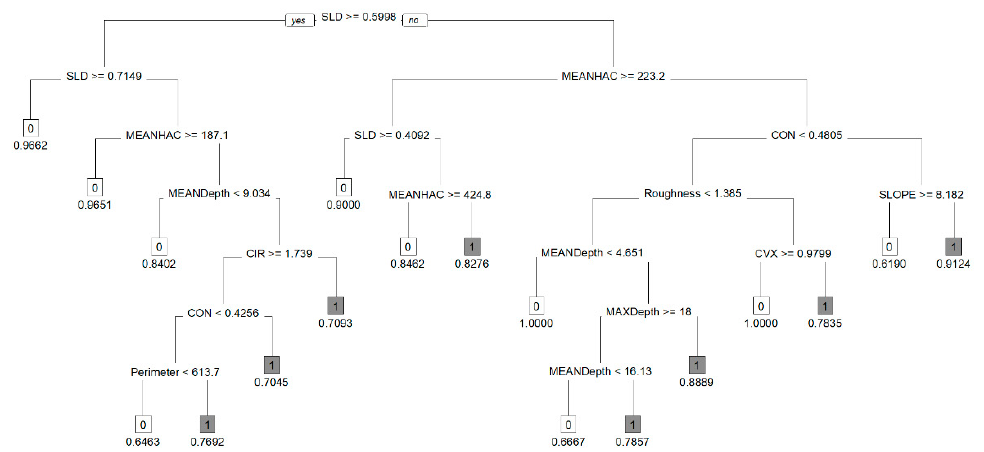
Figure 3. Classification trees for the Boone River watershed ( Top Left ); North Raccoon River watershed ( Top Right ); Rock River watershed ( Middle Left ); watersheds within the Des Moines Lobe Ecoregion ( Middle Right ); all watersheds together ( Bottom ). Terminal nodes that classified target features are within grey boxes. Values representing the conditional probability of the fitted class are underneath boxes at terminal nodes.